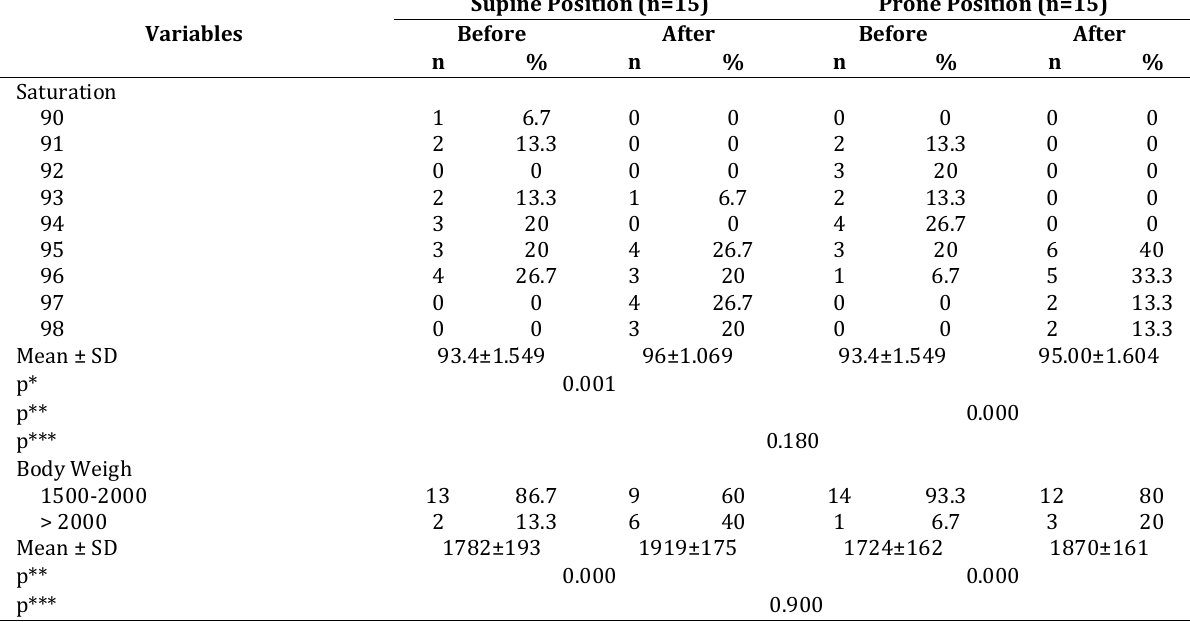
Table 2. Oxygen Saturation and weigh Before and After Using Nesting in supine and prone position (n=30) Prone Position (n=15) Variables Before After Before